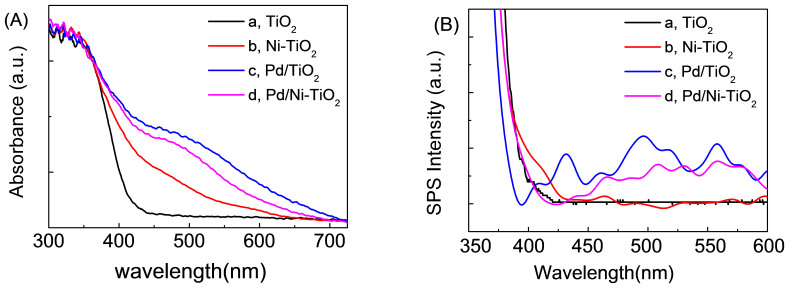
Optoelectronic properties of the as-prepared photocatalysts.(A) UV-vis absorption spectra and (B) surface photovoltaic spectra (SPS). (a) TiO2, (b) Ni-TiO2, (c) Pd/TiO2 and (d) Pd/Ni-TiO2.